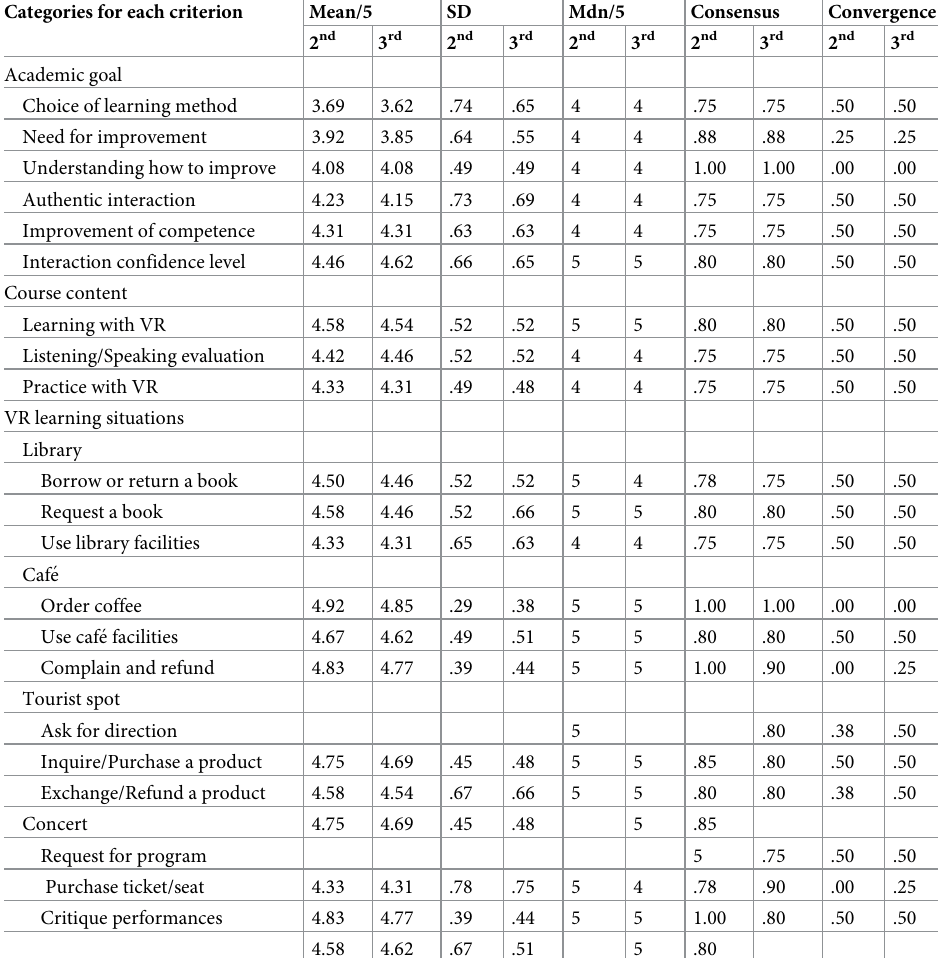
Table 6. Level of agreement with the appropriateness of the questions (second and third Delphi survey